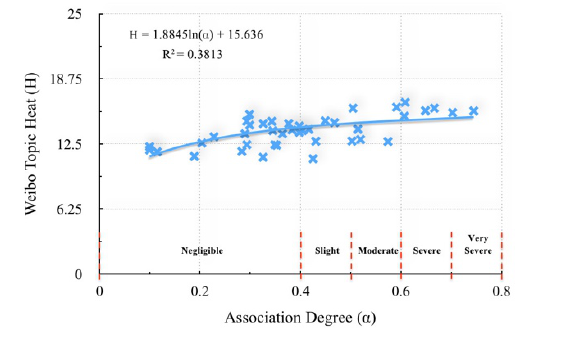
Figure 3. The fitting curve of Weibo Topic Heat and Association Degree